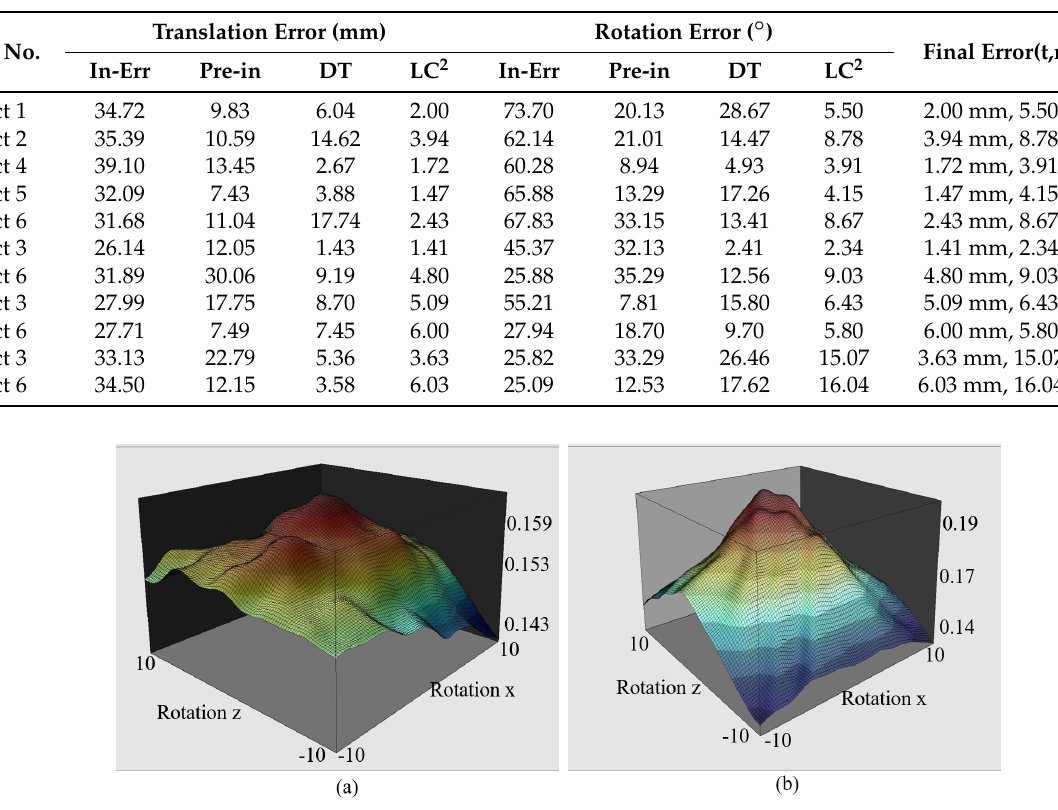
Figure 5. Surface plots of LC 2 cost function against rotation parameters when ( a ) registration is performed directly after Pre-in, without including the DT step and ( b ) registration is performed with the DT